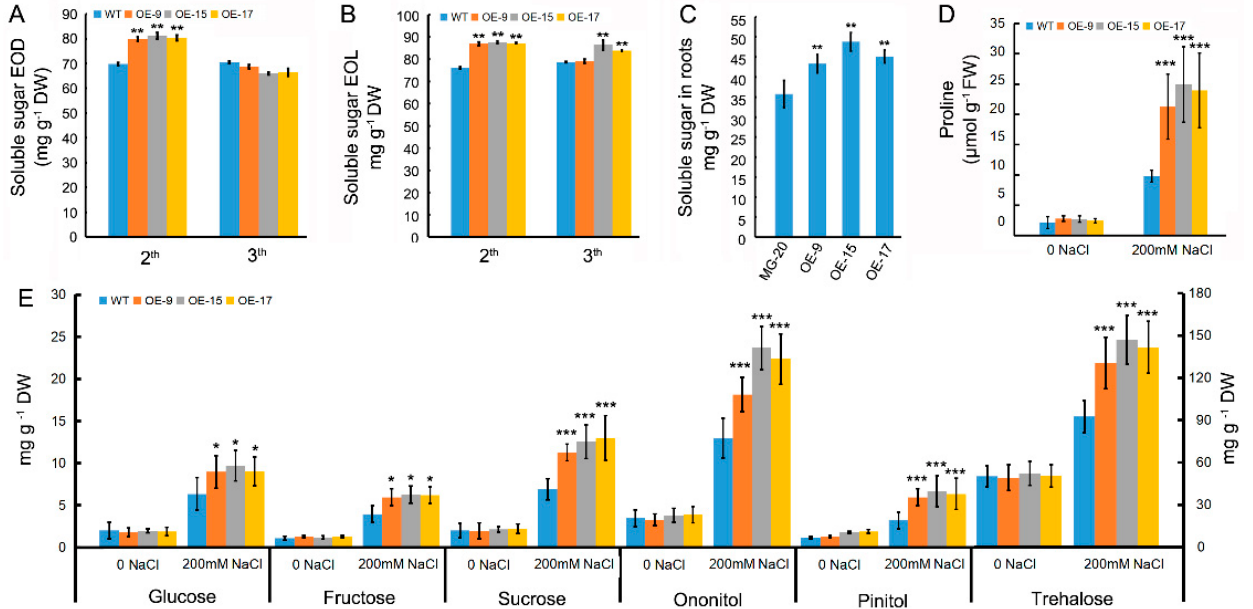
Figure 3. The changes of sugars/sugar alcohols in OELjPLT1 plants. ( A , B ) Soluble sugar concentra- tion of leaves at the end of the day period ( A , EOD) and end of the light period ( B , EOL). ( C ) Soluble sugar concentration in roots of eight-week-old plants. ( D ) Proline concentration in wild type and OELjPLT3 leaves after NaCl treatment. ( E ) The concentration of sugars/sugar alcohols in the wild type and OELjPLT3 leaves after NaCl treatment. Leaves of eight-week-old plants were collected from the indicated leaf position from top to bottom in A and B. Seven-week-old plants were irrigated with 200 mM NaCl and leaves were collected for the measurement of proline, sugars, and polyols in D and E. Error bars represent the SD of three biological replicates. The significant differences were assessed using one-way ANOVA (*, p < 0.05; **, p < 0.01; ***, p < 0.001). Given that proline and sugar products can be used as markers of environmental stress [4,32], concentrations of these small organic molecules were measured at 6 DAT. There were no significant differences in proline and sugar concentrations between different genotypes in the control group. The increased concentration of proline in OELjPLT3 leaves was greater than that in the wild type at 6 DAT as predicted (Figure 3D). The accumulation of glucose, fructose, sucrose, trehalose, ononitol, and pinitol in OELjPLT3 leaves reached higher levels than those in the wild type at 6 DAT as well (Figure 3E), which